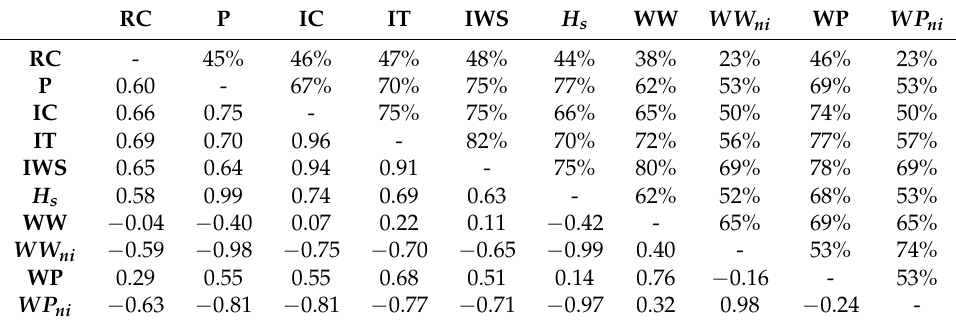
Table 1. The correlation (below diagonal) and percentage of nodes within the SEEZ with the average relative suitability index above 0.4 (above diagonal) for both combined aspects given by the first row and first column. The aspects considered are: scaled Relative Classes from Nilsson et al. [6] ( RC ), wave Power ( P ), Ice Concentration ( IC ), Ice Thickness ( IT ), Ice/Wind Speed ( IWS ), significant wave height ( H s ), Weather Windows ( WW ), weather windows (ignoring ice) ( WW ni ), mean Waiting Periods ( WP ), and mean waiting periods (ignoring ice) ( WP ni